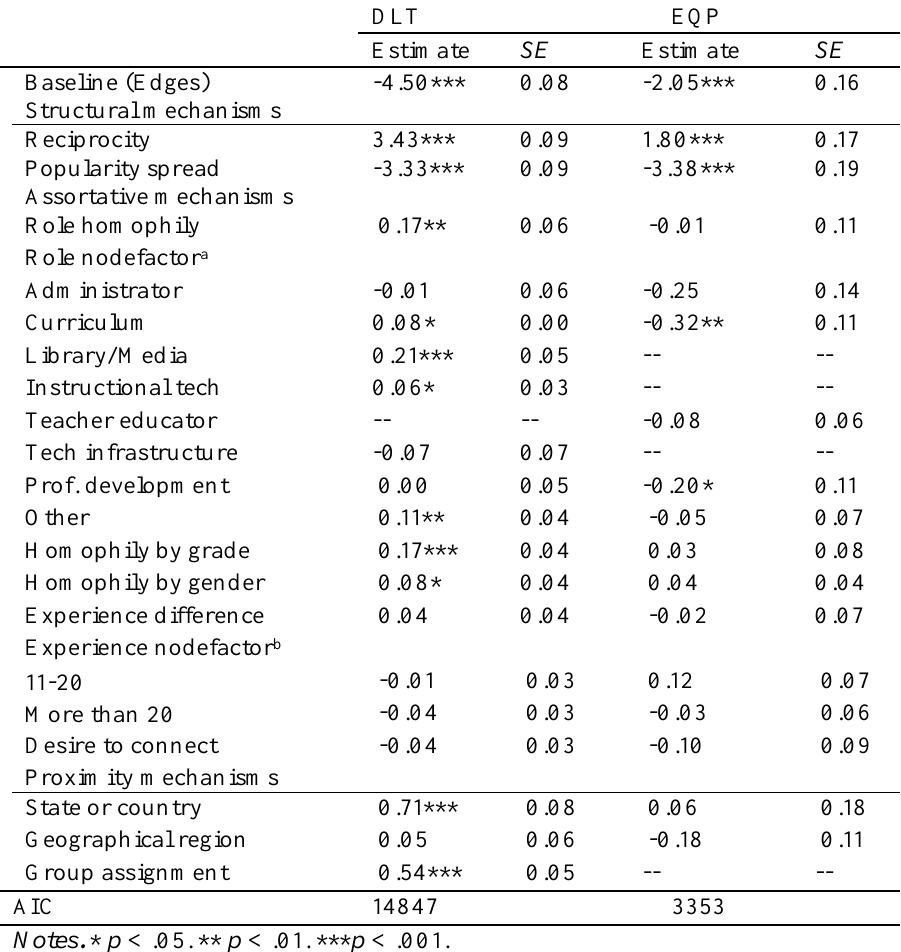
Table 3 Summary of ERGM Model, Estimates and